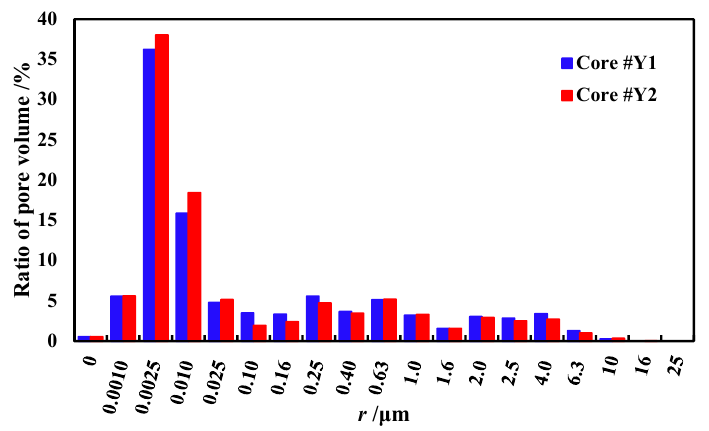
Figure 7. The histogram of pore radius distribution. Table 2. Relationship between T 2 , pore radius, and pore type.